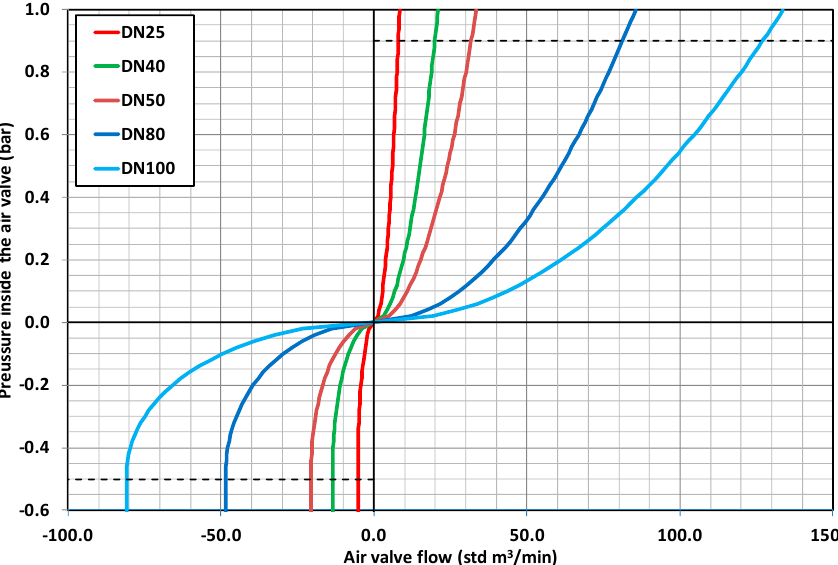
Figure 2. Air valves technical information provided a manufacturer.